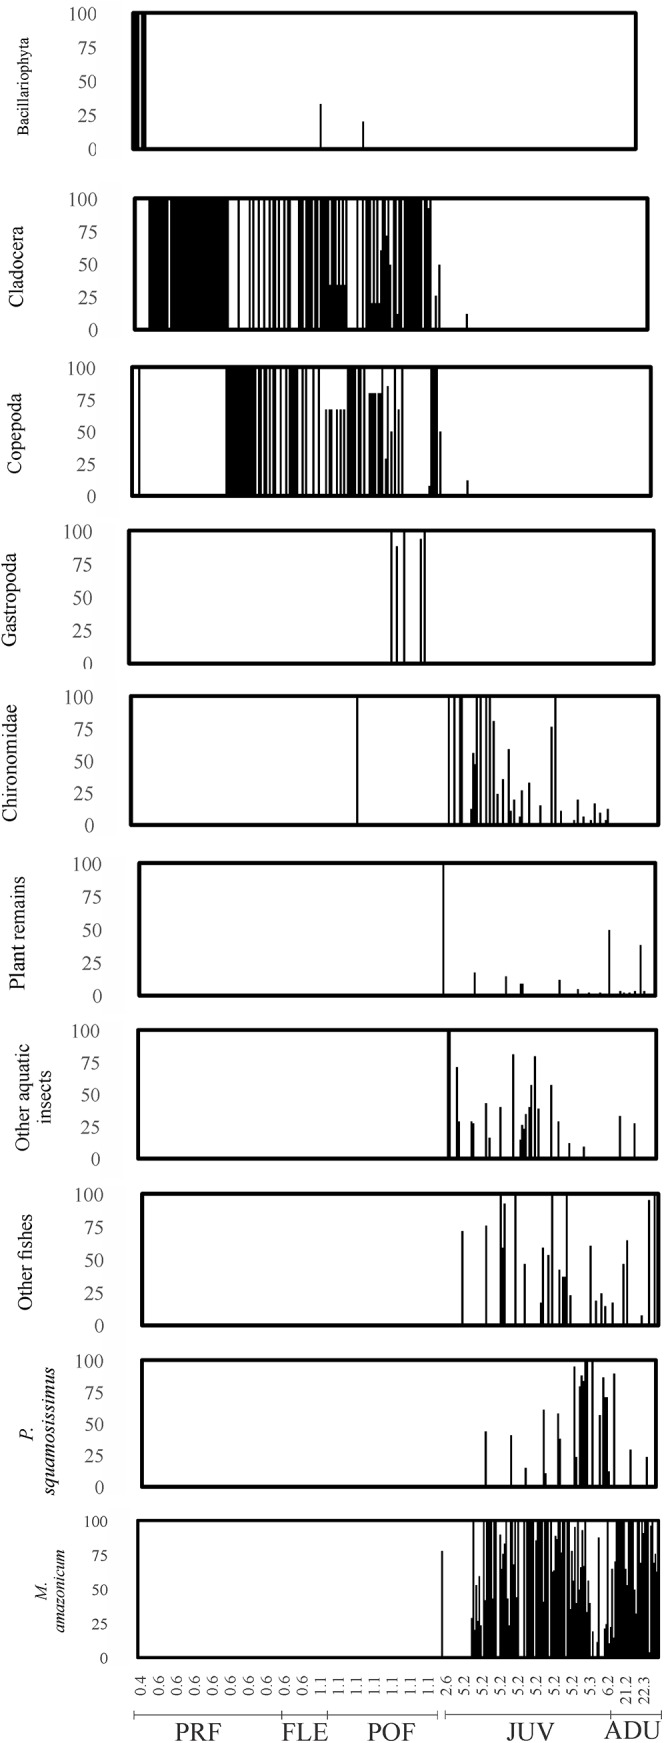
Percentage of the food item in relation to total consumption of food items according to the standard length of P. squamosissimus in Xambrê Lake, Upper Paraná River floodplain, Paraná State, Brazil.